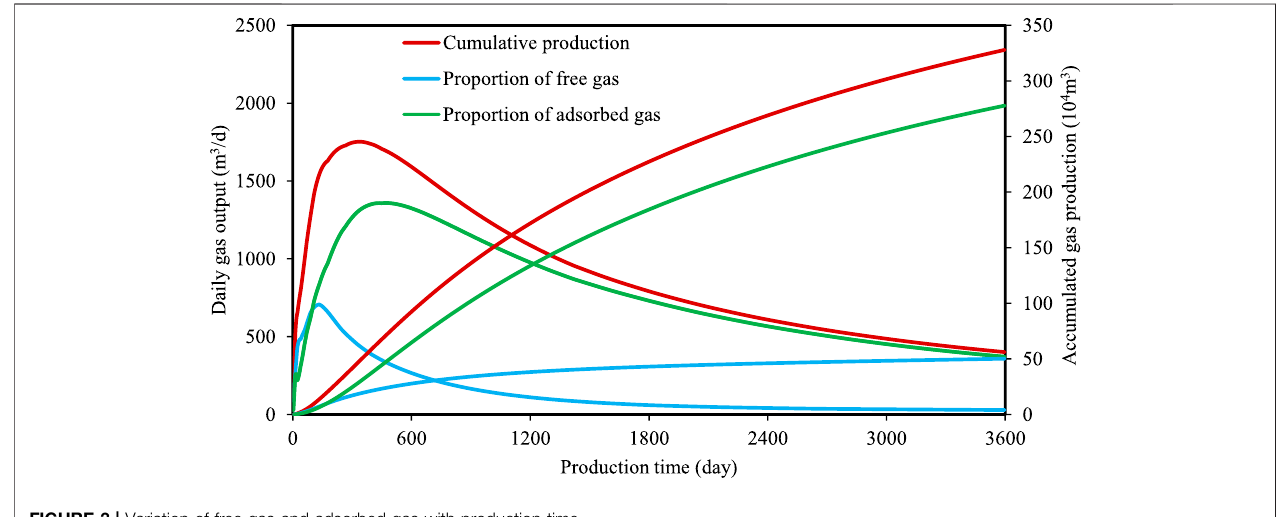
FIGURE 3 | Variation of free gas and adsorbed gas with production